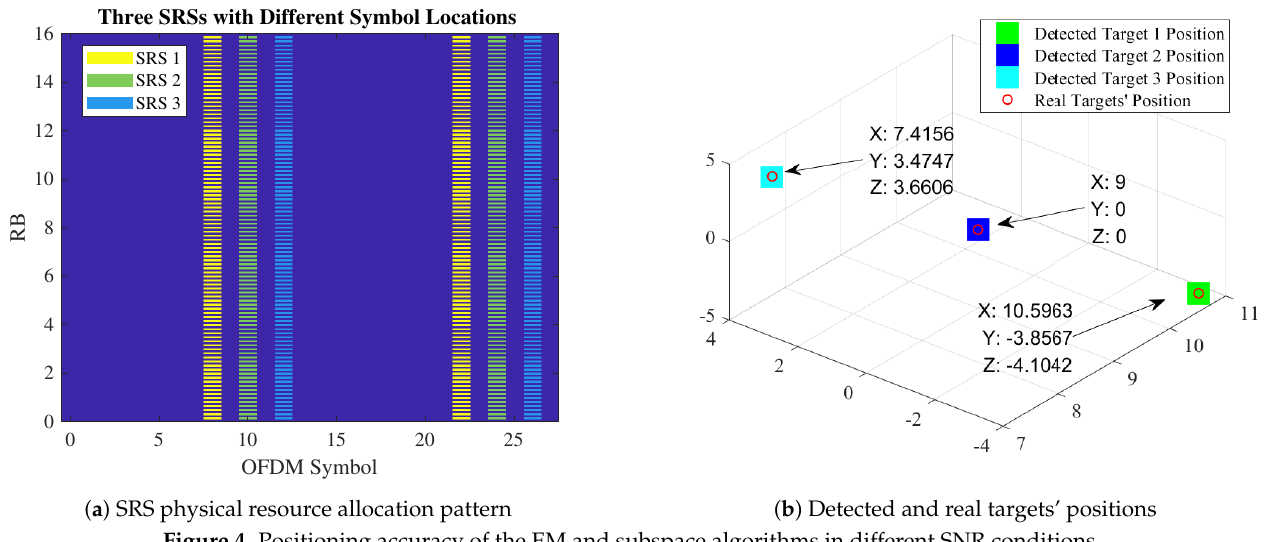
Figure 4. Positioning accuracy of the EM and subspace algorithms in different SNR